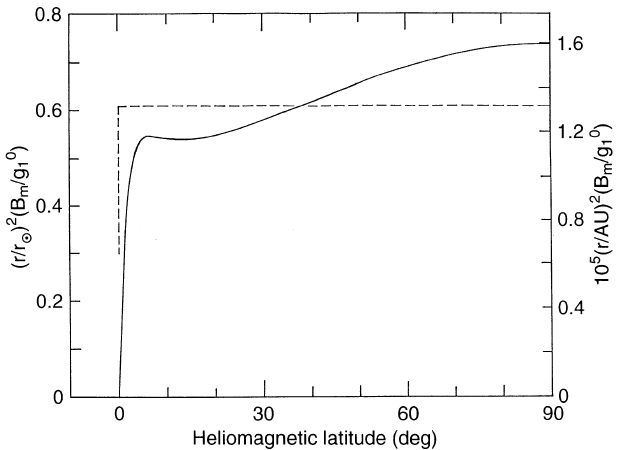
Fig. 3. Variation of meridional (asymptotically radial) component of 2 B [component denoted ( r 2 B ( r = r = r (cid:12) (cid:134) m ] with heliomagnetic latitude (cid:12) (cid:134) (cid:107) (cid:133)(cid:17) 90 (cid:14) (cid:255) (cid:104) ) in the limit r !1 , in a source-surface model with k (cid:136) 7 = 5 for the case in which the Sun’s field is dipolar. For comparison ( dashed step-function ): hypothetical case (quite well approximated (Schulz et al. , 1978) by a source-surface model with k (cid:136) 0) in which magnetic flux is uniformly distributed over either